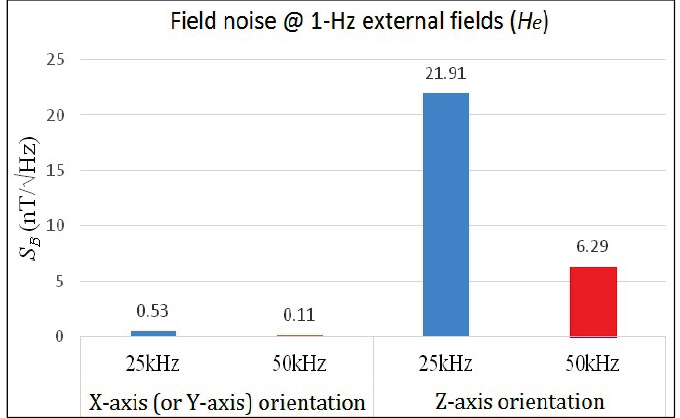
Figure 12. Comparison of the maximum field noise spectral density results under different excitation frequencies in X- and Z-axis.